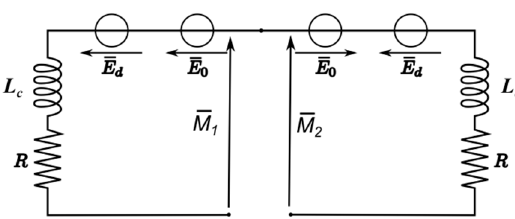
Figure 8. Principle of experimental measurements of the EMF shown on equivalent electrical circuit.